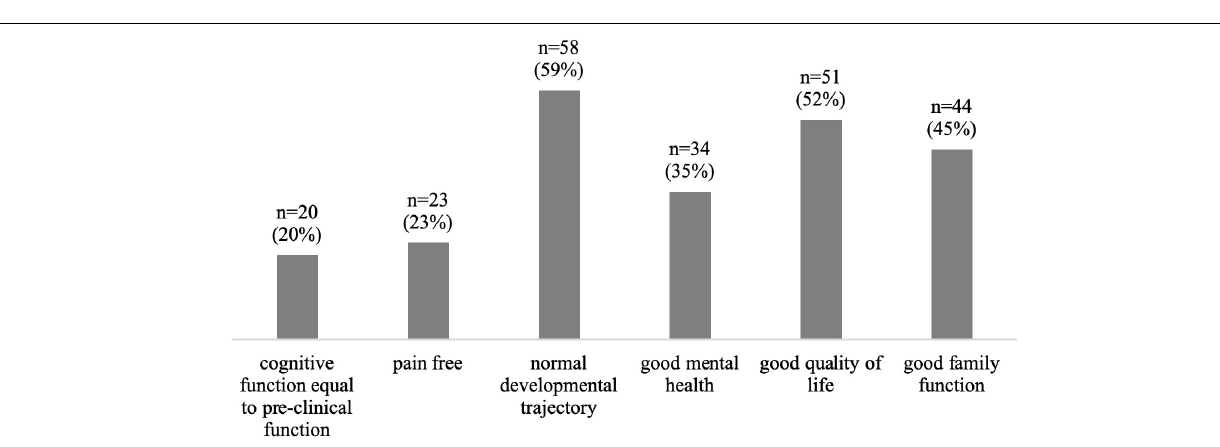
FIGURE 3 | Most frequent selected significant outcome parameters after PICU treatment; n = 98 (multiple